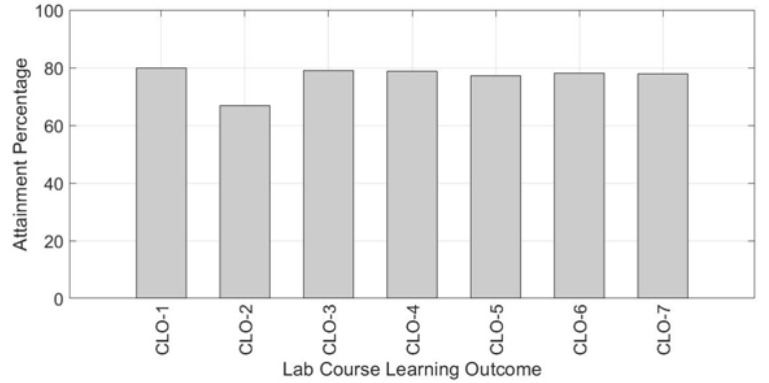
Figure 6. Attainment percentage of the lab course CLOs for students not taking the lecture-based course